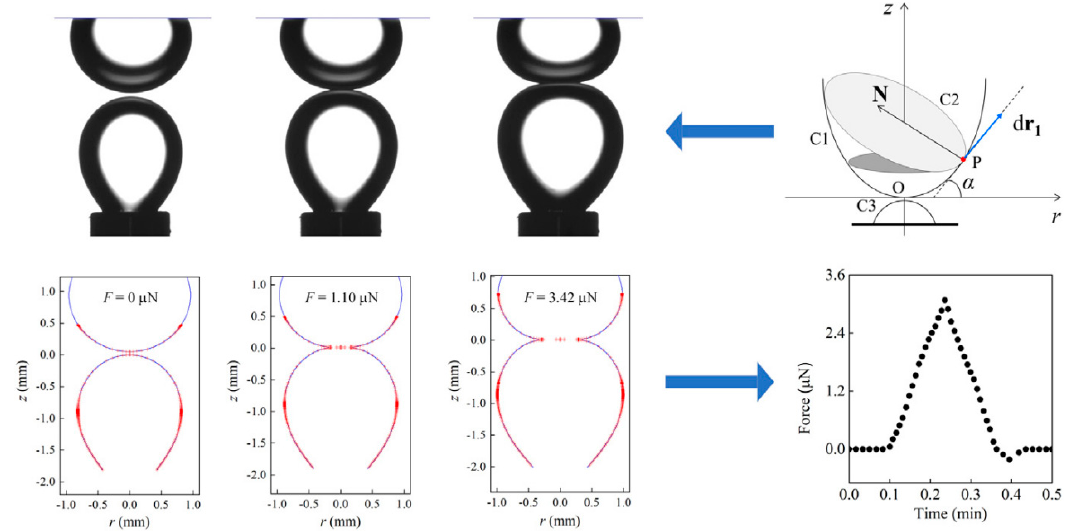
Figure 10. Measuring the force between two droplets by using profile deformation. Reprinted with permission from Ref. [140]. 2022, Elsevier. Table 7. Comparison of force measurement tools.